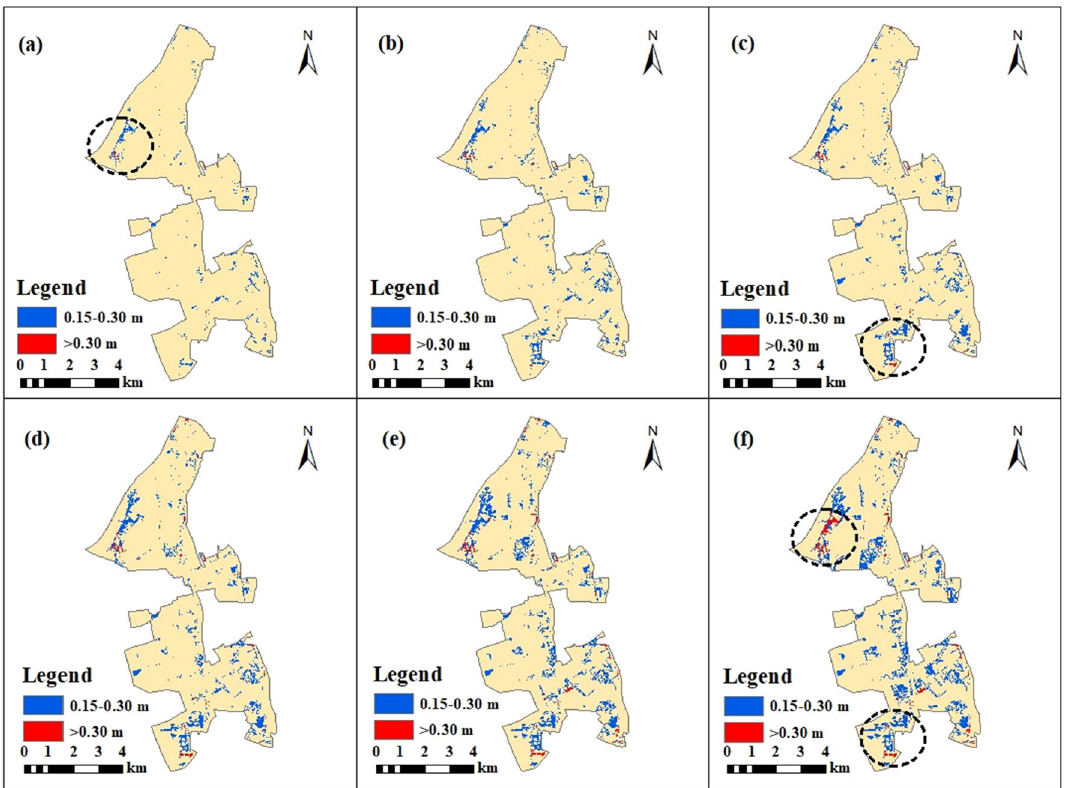
Figure 7. Flooded area under different rainfall return periods including ( a ) Return Period = 2a; ( b ) Return Period = 5a; ( c ) Return Period = 10a; ( d ) Return Period = 20a; ( e ) Return Period = 50a; ( f ) Return Period = 100a. This map was generated with ArcMap Version 10.0. (https:// www. esri. com/ en- us/ arcgis/ produ cts/ arcgis- deskt op/ overv iew).